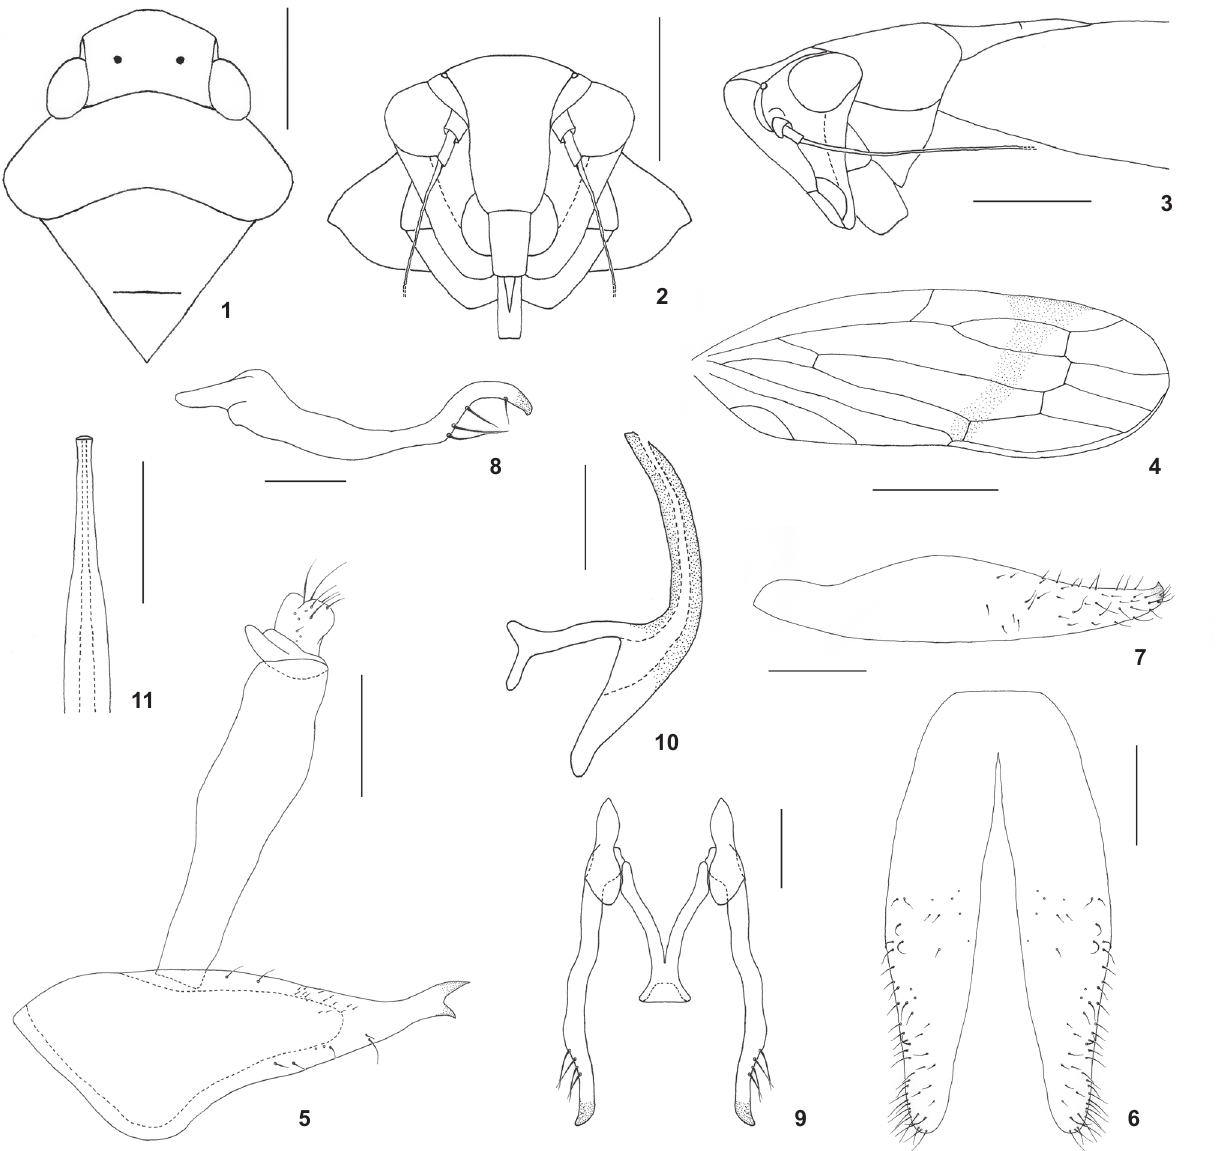
Figures 1-11, Aglaenita hambletoni sp. nov. , male holotype: (1) head, pronotum and mesonotum, dorsal view; (2) head and thorax, frontal view; (3) head, thorax, forecoxa and base of forewing, lateral view; (4) forewing; (5) pygofer and anal tube, lateral view; (6) subgenital plates, ventral view; (7) subgenital plate, lateral view; (8) style, lateral view; (9) styles and connective, dorsal view; (10) aedeagus, lateral view; (11) apex of aedeagus, ventral view. Scale bars: 1-3 = 1.0 mm, 4 = 2.0 mm, 5-7 = 0.5 mm, 8-11 = 0.3